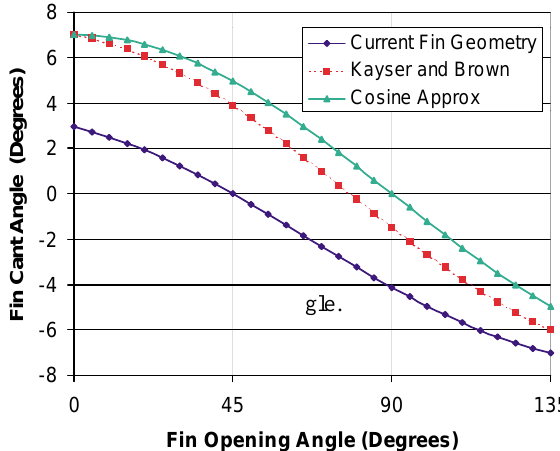
Fig. 5. Effective fin cant angle as a function of fin opening angle.